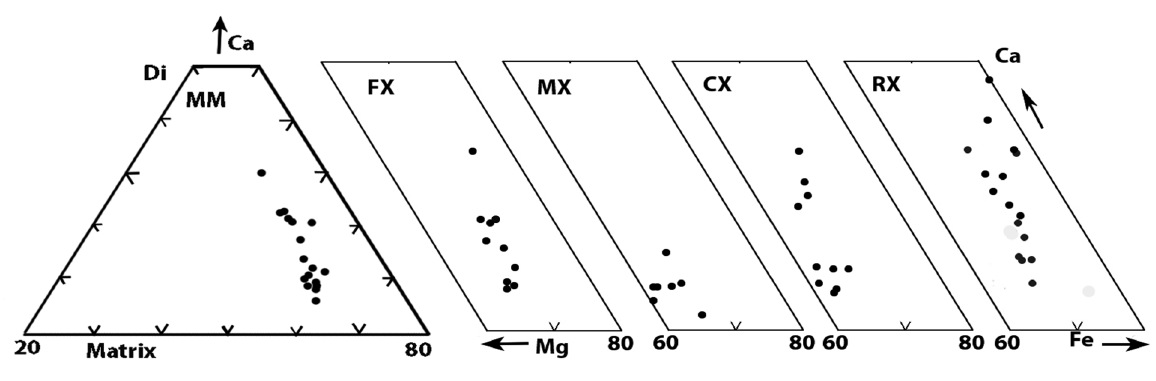
Figure 4 - Pyroxene ternary diagram showing the composition of pyroxene in matrix and clasts in Serra Pelada meteorite.